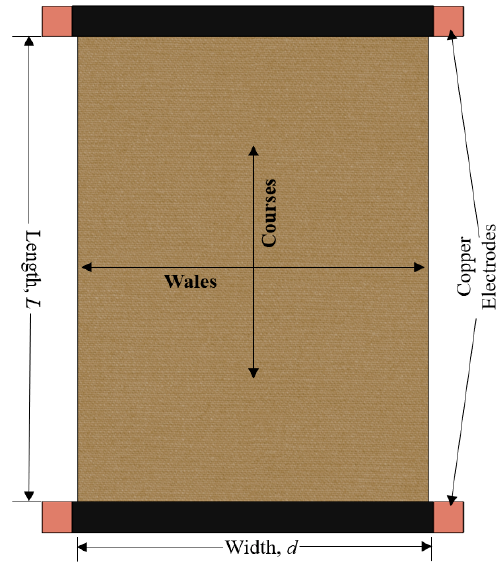
Figure 2. Arrangement of fabric for resistance assessment.